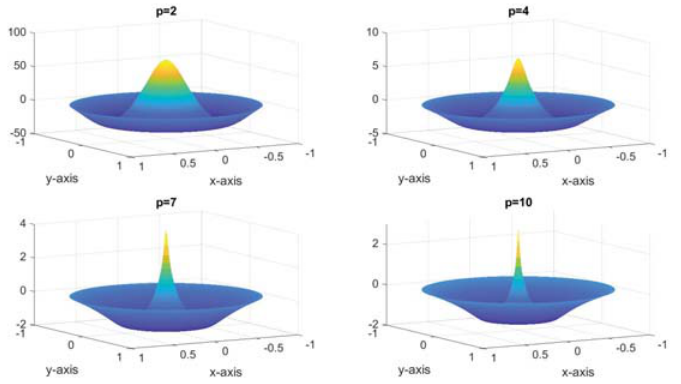
Fig. 1: Radially symmetric numerical solutions with two nodal regions